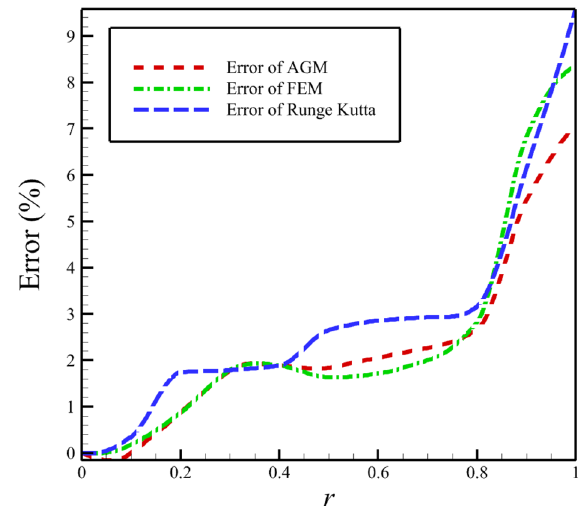
Fig. 4 Differences between FEM with the result of S. DAS, ref [32] Fig. 5 Differences between AGM, FEM, and Runge–Kutta with the result of S. DAS, ref